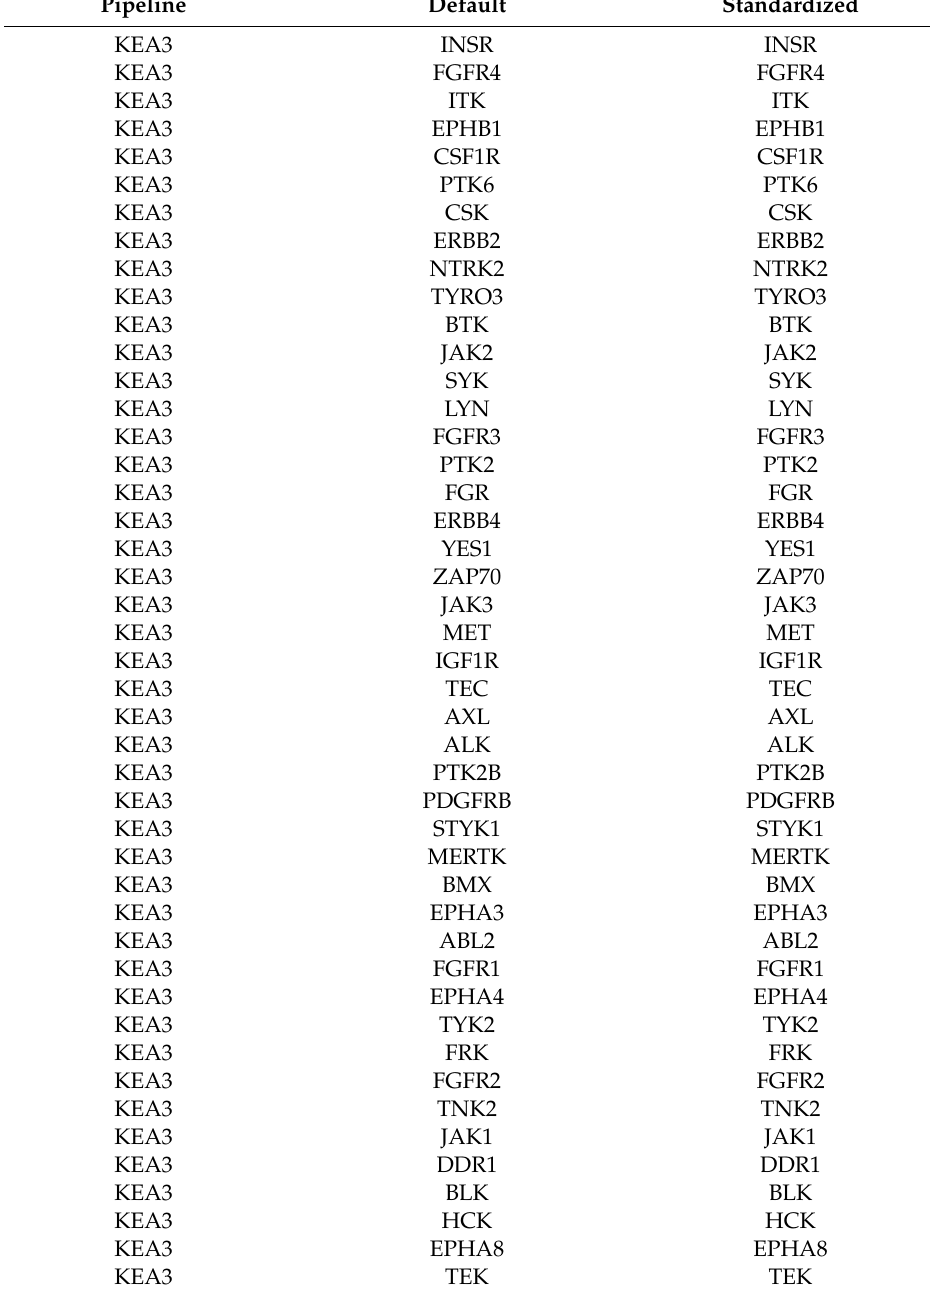
Figures 2–4 , expanded figure legend. Default outputs from upstream kinase identification pipelines for PDAC cell lines compared to patient-derived wild-type pancreatic tissue. ( A ) The Kinome Random Sampling Analyzer (KRSA) pipeline identifies di ff erentially active upstream kinases according to mean standard score (Z) values on the x axis, with kinase family on the y axis, and color gradation representing absolute mean standard score. Full red represents an absolute mean standard score above 3 and full white represents an absolute mean standard score below 1. Absolute mean standard scores for each kinase family are calculated by averaging the absolute standard score values of nine standard scores, each derived from input lists consisting of peptide sequences with log-fold change (LFC) in phosphorylation above 0.2, 0.3, or 0.4 in one of our three biological replicates. Each plotted box represents values within and including the first and third percentiles (the 25th and 75th percentiles). Upper or lower whiskers extend from the box to the largest or smallest kinase family standard score that is less than or equal to 150% of the distance between the first and third percentiles, respectively. Outliers defined as greater than 150% of the distance between the first and third percentiles are plotted individually.